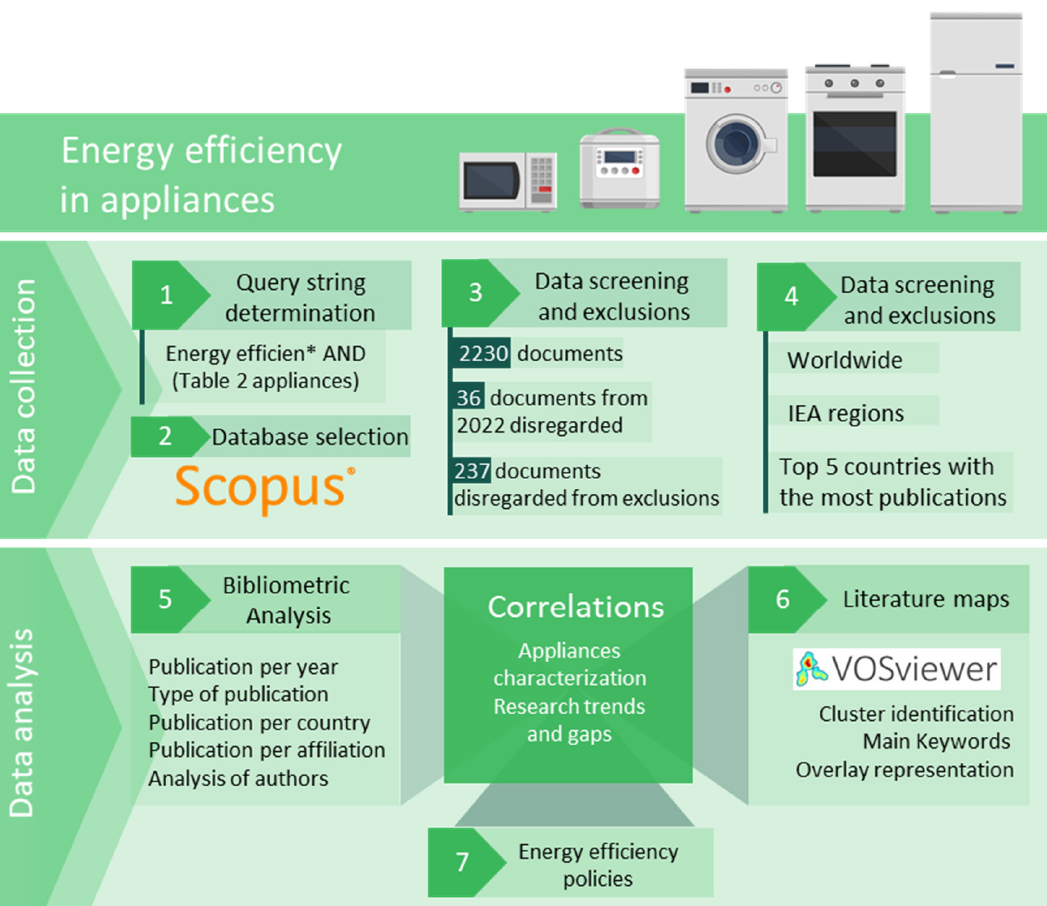
Figure 3. Methodology followed in the bibliometric analysis.